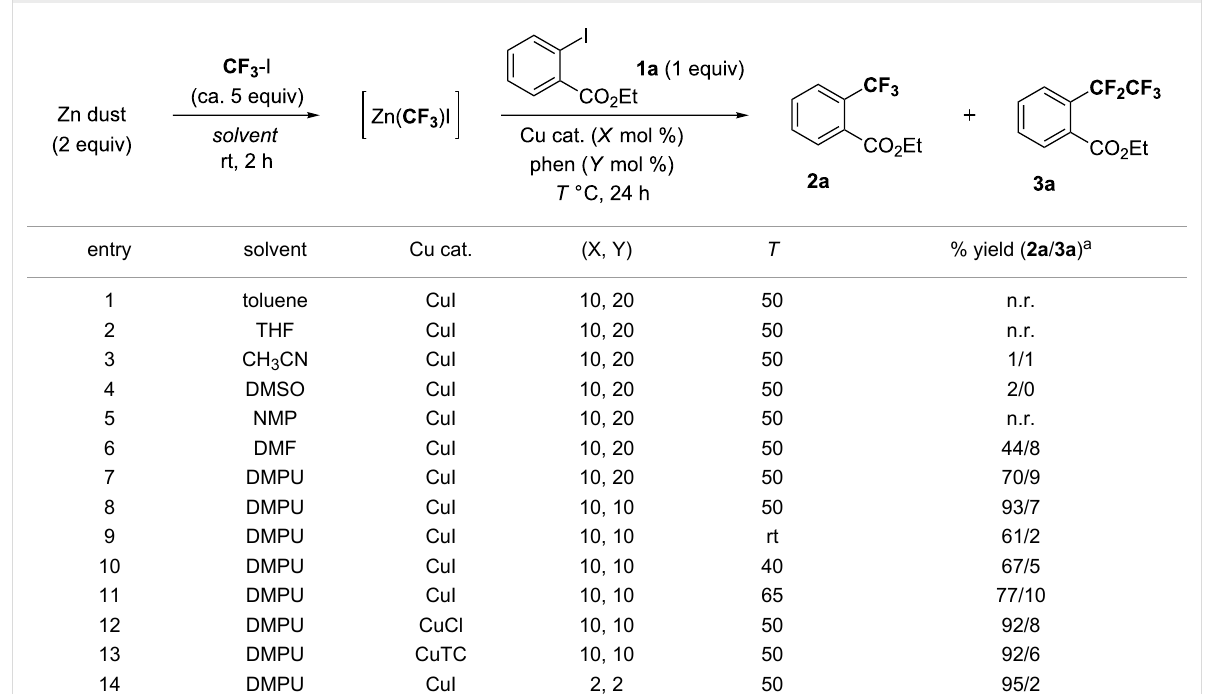
Table 1: Copper-catalyzed trifluoromethylation of aryl iodide 1a